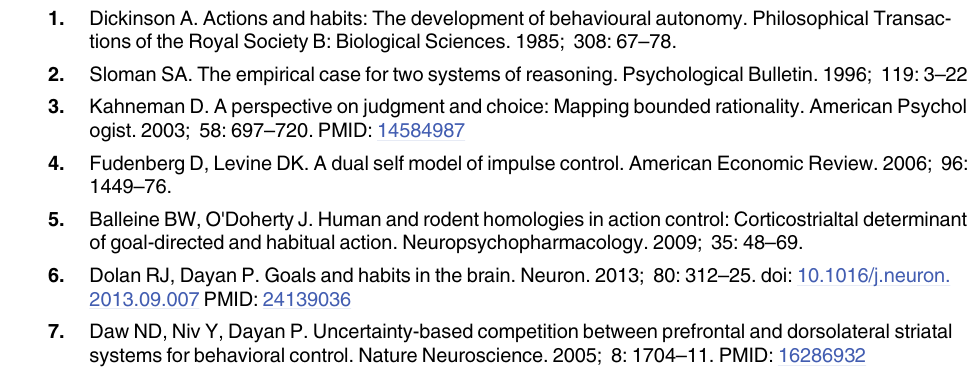
S1 Table. Model comparison for the full hybrid model and the hybrid model without choice perseveration parameters. S2 Table. Model comparison for the hybrid model and pure model-based and model-free